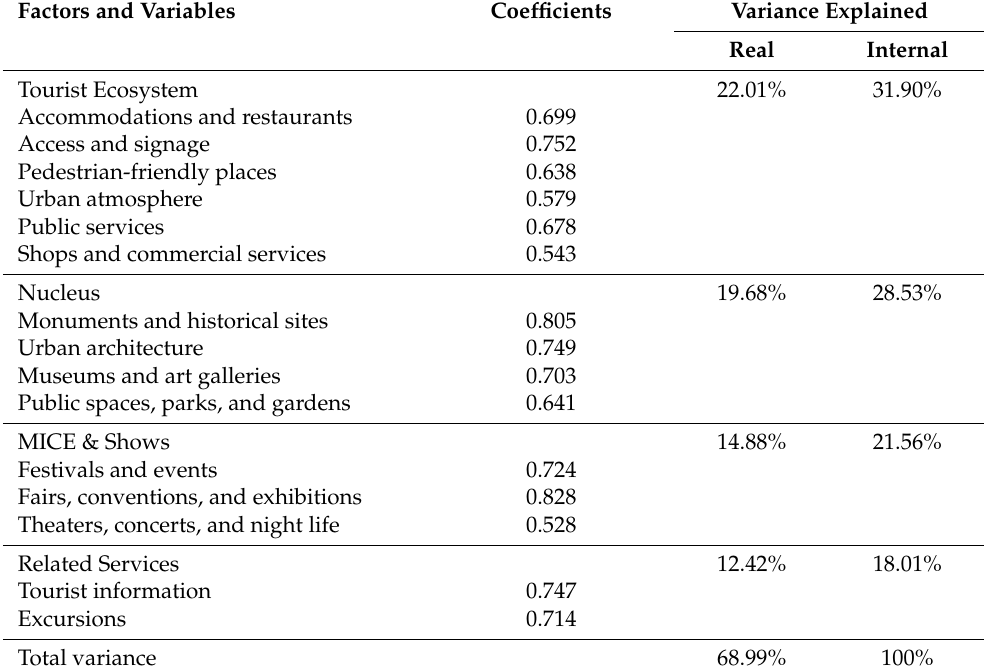
Table 3. Factor analysis (principal components).